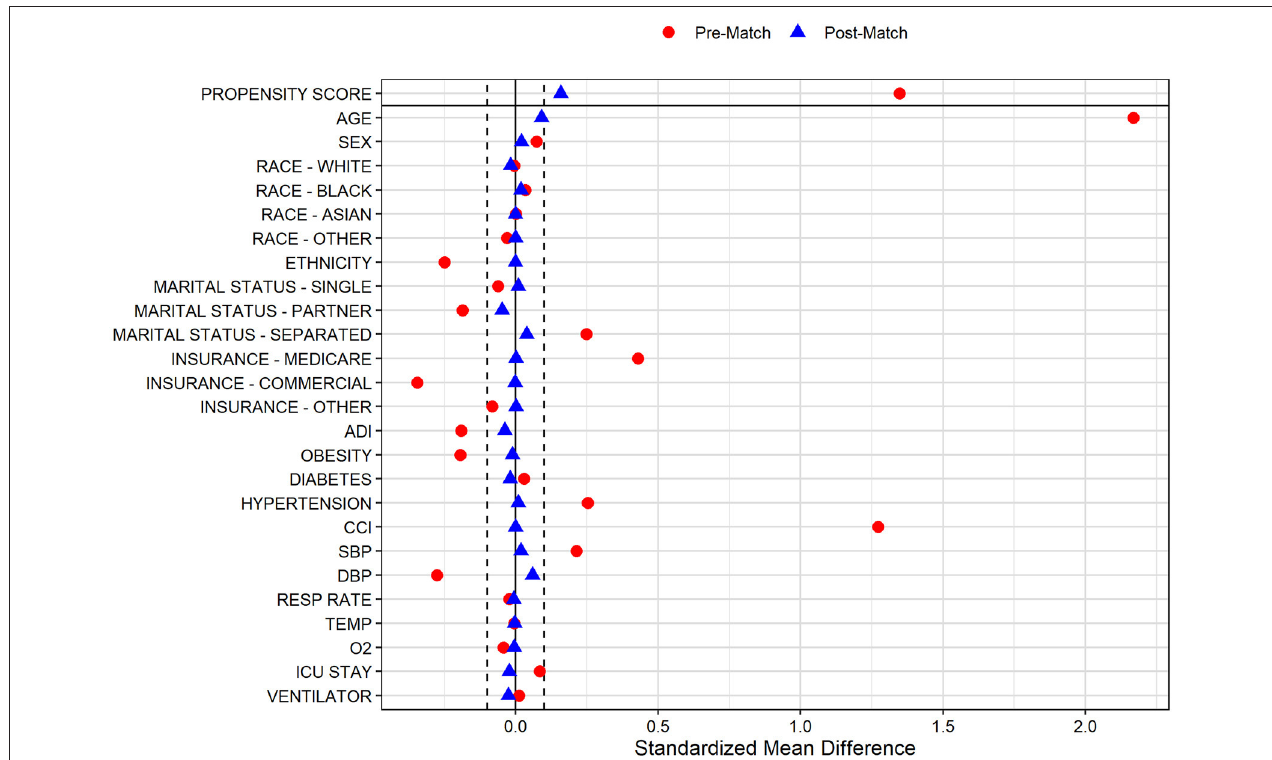
FIGURE 3 | Covariate and propensity score balance for COVID-19 mortality analyses. Pre- and post-matched standardized mean differences (SMD) are presented, using a SMD threshold of 0.1. Cohorts matched on age, sex, race, ethnicity, marital status, insurance coverage, area deprivation index (ADI), obesity, diabetes, hypertension, overall Charlson Comorbidity Index (CCI), mean systolic and diastolic blood pressure (SBP/DBP) at admission, elevated respiratory rate at admission, elevated temperature at admission, low oxygen saturation (O2) at admission, intensive care unit (ICU) stay, and mechanical ventilation